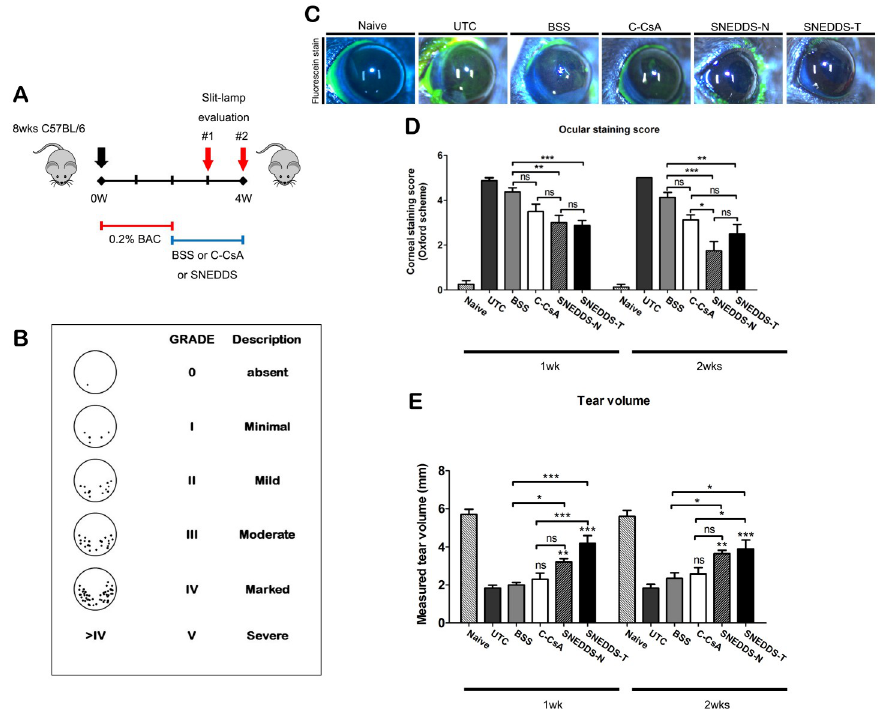
Fig 3. (A) Schematic diagram of experimental protocol of the murine benzalkonium chloride (BAC)-induced DED model and subgroups. (B) Schematic diagram of corneal fluorescein staining scoring system. (C) Representative images of corneal fluorescein staining in the untreated control (UTC), balanced salt solution (BSS)-treated, C-CsA- treated, SNEDDS-N-treated and SNEDDS-T-treated subgroups on week 2. (D, E) In vivo evaluations of dry eye murine model by (D) corneal fluorescein staining (n = 8) and (E) tear volume (n = 8) on weeks 1 and 2. Data are expressed as mean ± SD. � P < 0.05, �� P < 0.01, ��� P < 0.001 by independent t-test or one-way ANOVA.